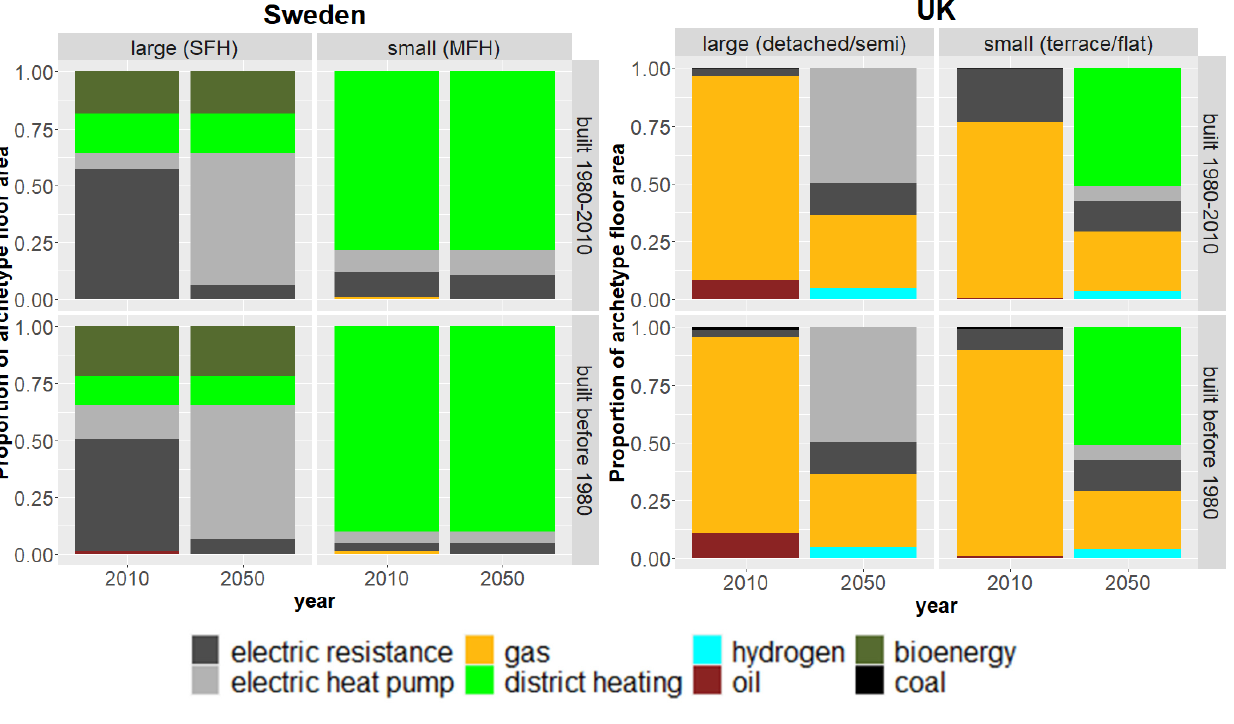
Figure A4. Share of floor area with each form of heating for the UK and Swedish dwelling archetypes in 2010 and 2050 (authors’ analysis).